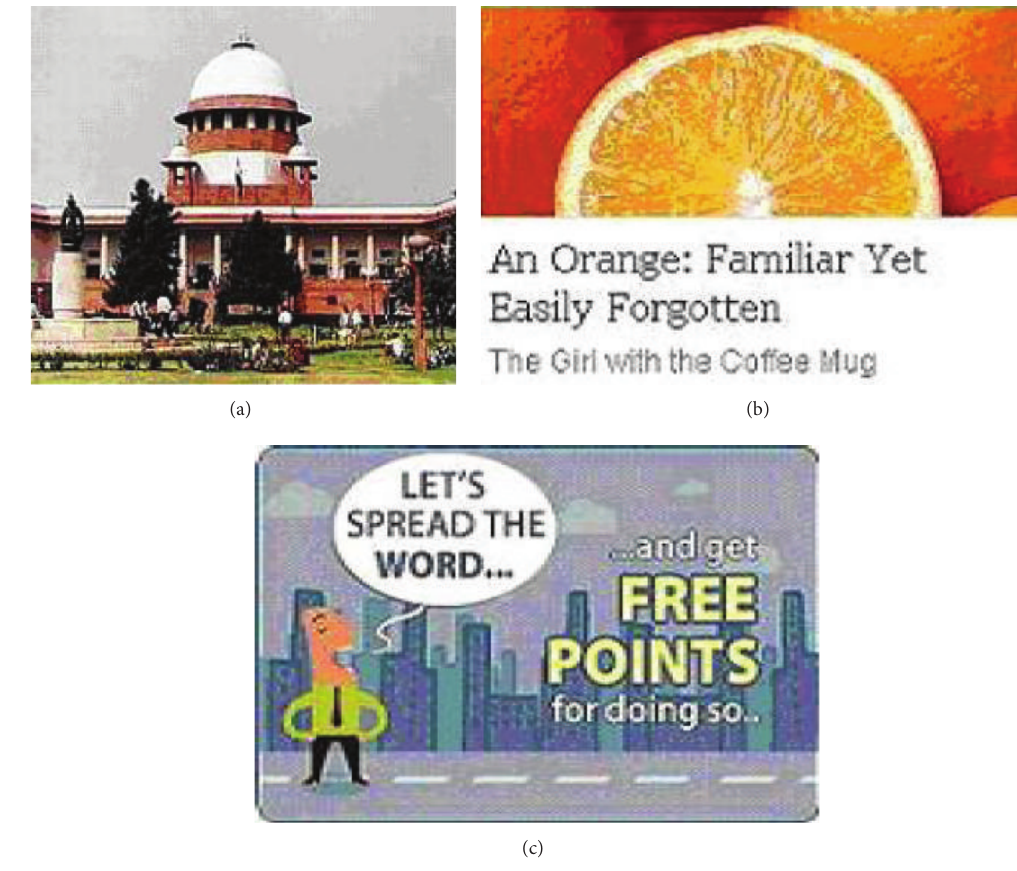
Figure 2: Examples of image objects. In (a), a pure image is shown. An image object with a caption is shown in (b) while in (c) an image with embedded text is